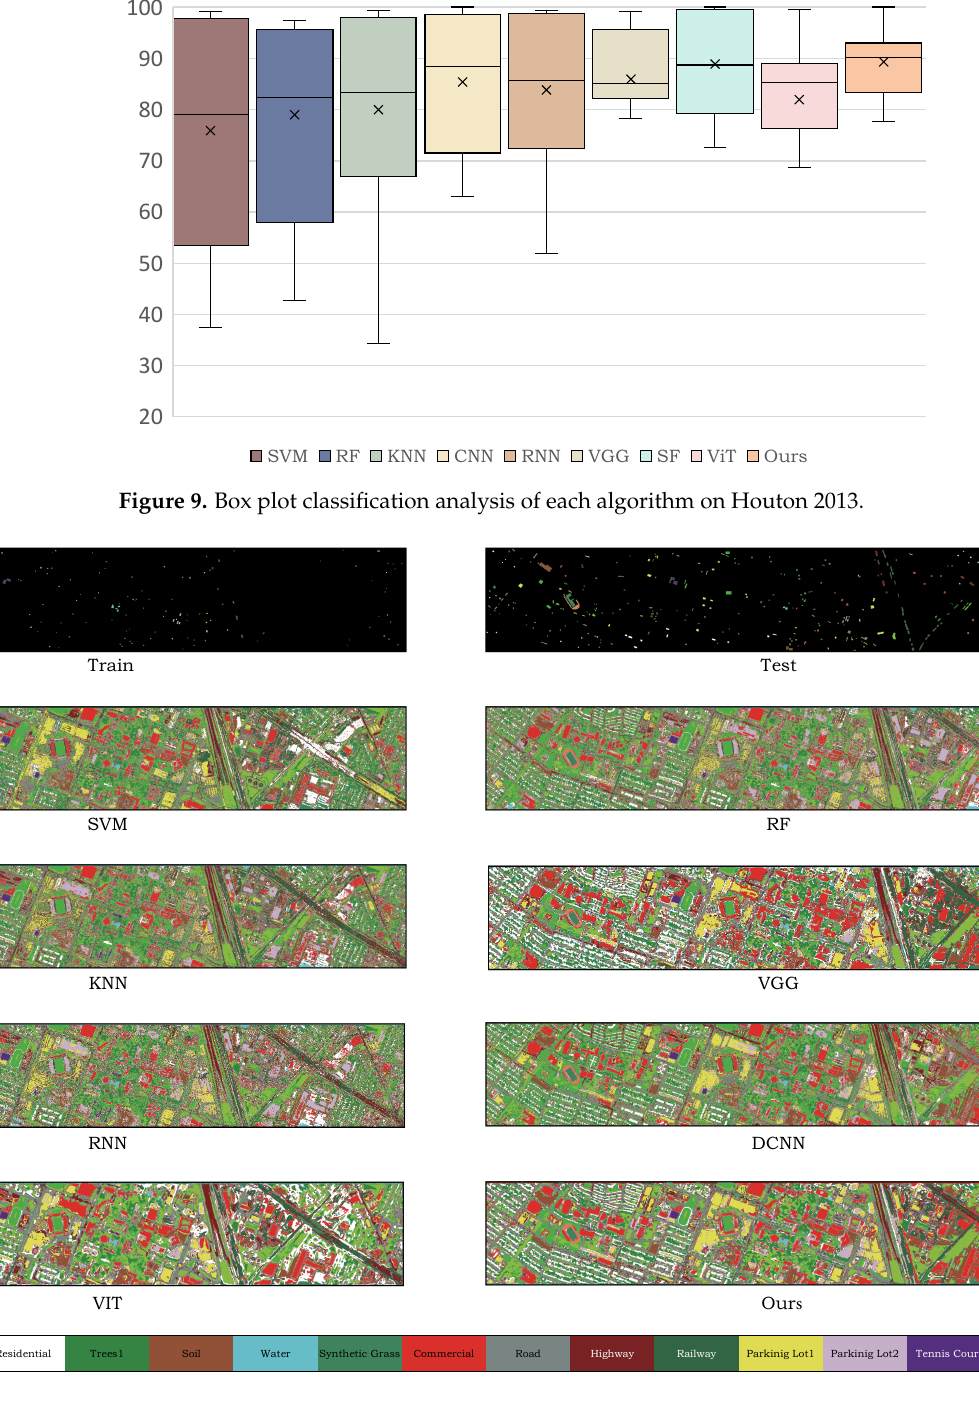
Figure 10. Visualization of results of different algorithms on Houston 2013